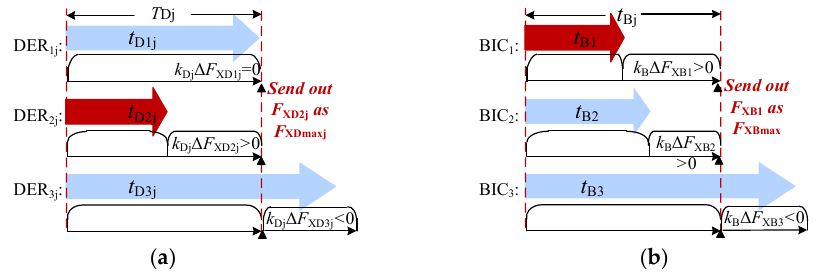
Figure 5. Mechanism of local weight selecting method. ( a ) selection process of the 1st DL, ( b ) selection process of the 2nd DL.